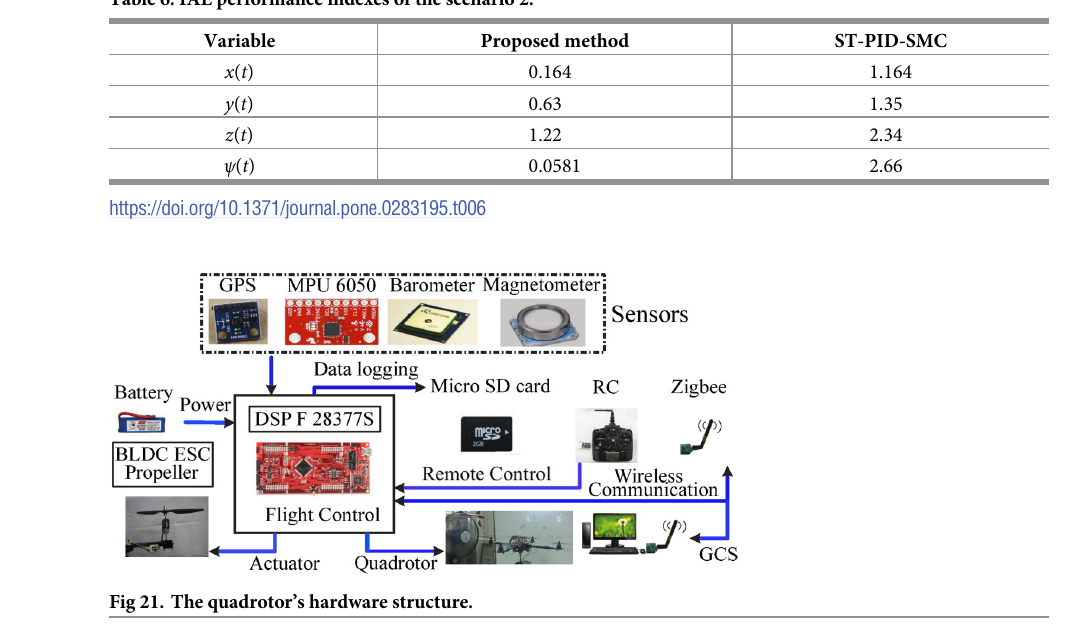
Table 6. IAE performance indexes of the scenario 2.